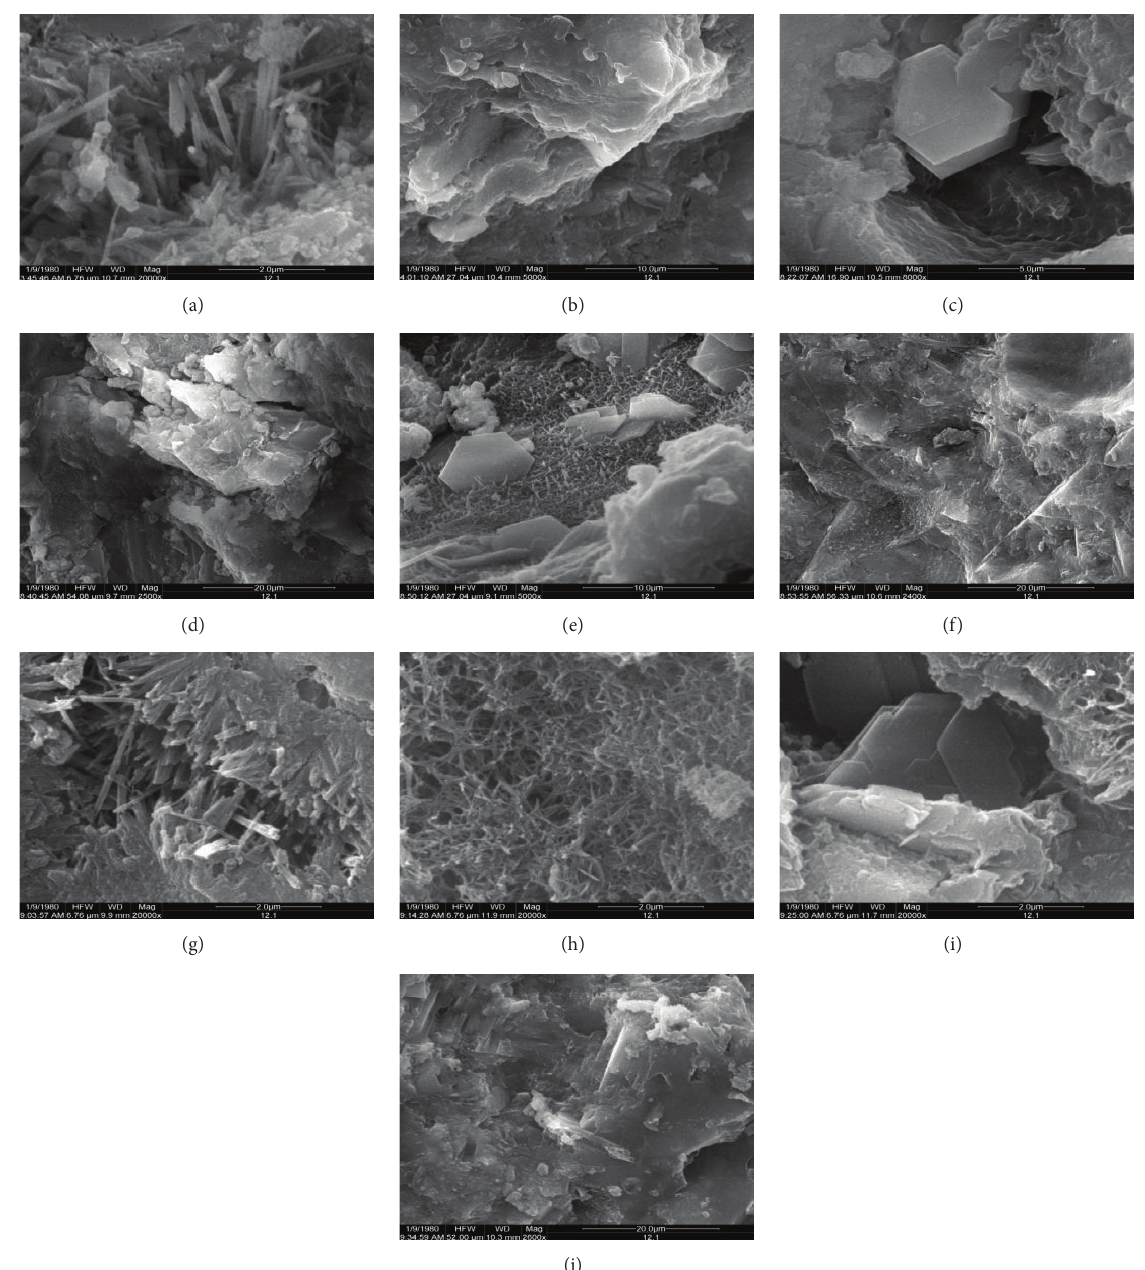
Figure 7: SEM images of each sample ((a) NPC 28 d, (b) NPC 90 d, (c) GL 28 d, (d) GL 90d, (e) GS 28 d, (f) GS 90d, (g) LS 28 d, (h) LS 90 d, (i) GLS 28 d, and (j) GLS 90